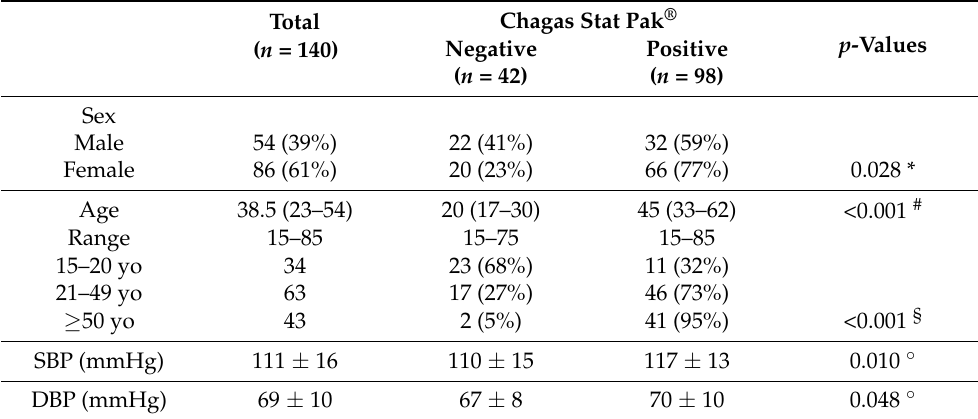
Table 1. Characteristics of the surveyed population in a rural community of the Bolivian Chaco by T. cruzi infection